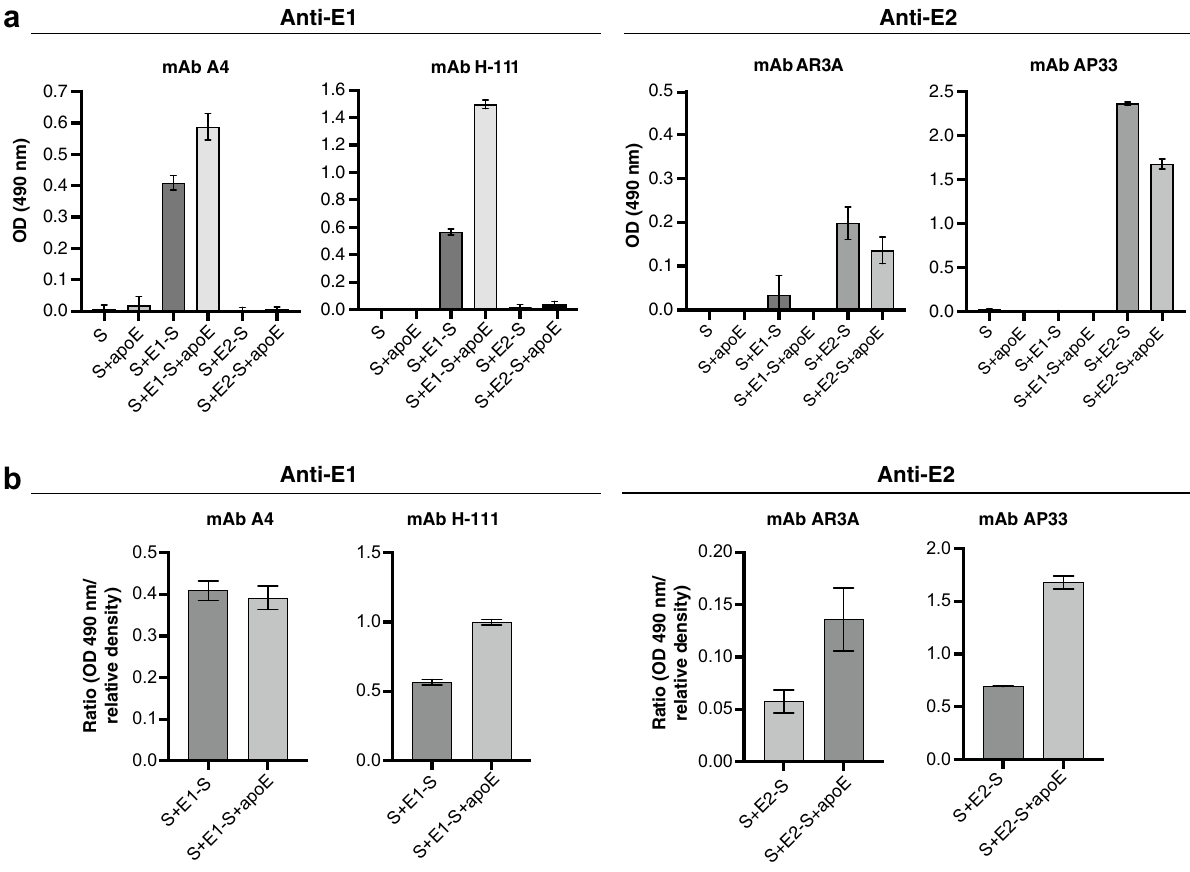
Figure 3. Analysis of the incorporation of E1-S and E2-S proteins and their presentation in purified HBV–HCV subviral particles . ( a ) Detection of HCV E1 or E2 proteins on the surface of SVPs by ELISA. Subviral particles (25 µg SHBsAg) were captured with an anti-S pAb (70-HG15), and proteins were detected on the surface of the particles with anti-E1 (mAbs A4 and H-111) or anti-E2 (mAbs AR3A and AP33) antibodies. Experiments were performed once in triplicate and results are expressed as the mean OD (490 nm) values ± SD. ( b ) The levels of chimeric HBV–HCV E1-S or E2-S proteins detected were normalized according to the amount of each protein incorporated into the subviral particles. The results are expressed here as the ratio of OD (490 nm) values obtained for the detection of chimeric HBV–HCV proteins by ELISA to the relative density of bands for the same proteins in subviral particles (Fig. 2a) ±